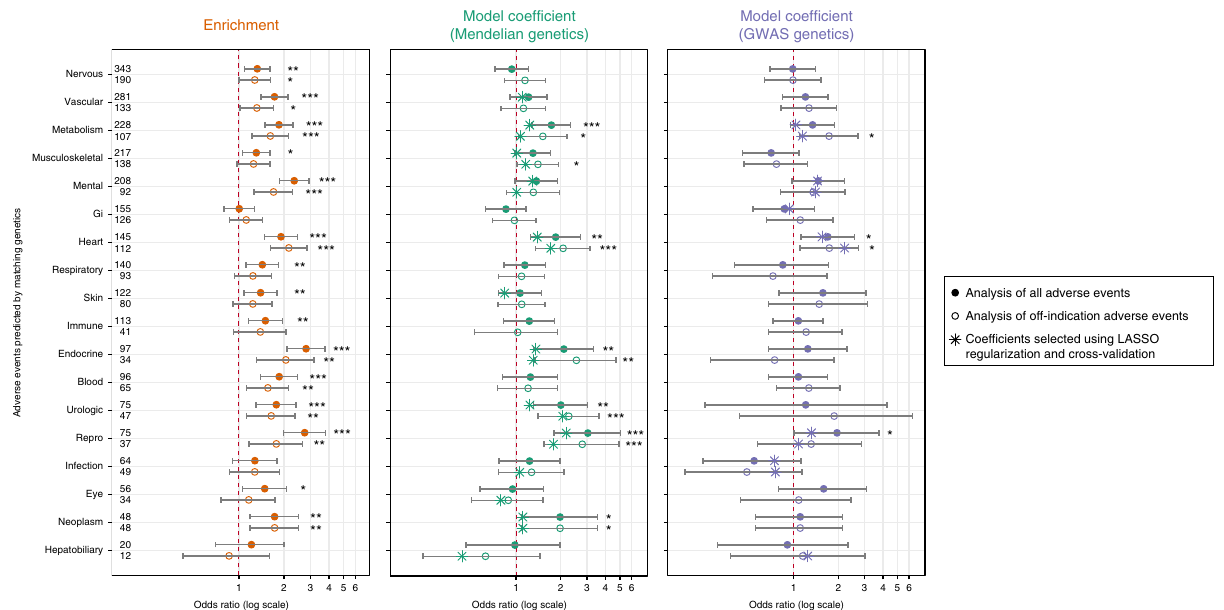
Fig. 3 Summary of side effect modeling results. Left: results of raw enrichment analysis (source data from Supplementary Table 2). Center: coef fi cients of the Mendelian genetics predictors in each of the 18 side effect models (source data from Supplementary Table 3). Right: coef fi cients of the GWAS genetics predictors in each of the 18 side effect models (source data from Supplementary Table 3). Coef fi cients from the regression models were exponentiated to obtain odds ratios. Along each row, circular points indicate odds ratios from the glm models; error bars are 95% con fi dence intervals from the glm models; large eight-pointed stars indicate odds ratios when the genetics predictors are selected as predictors in the glmnet models (which are built using feature selection, lasso regularization, and cross-validation). Small asterisks offset from the data indicate P -values of the the Fisher ’ s exact test (left) and P -values of the coef fi cients from the glm models (center and right) (* P < 0.05; ** P < 0.01; *** P <